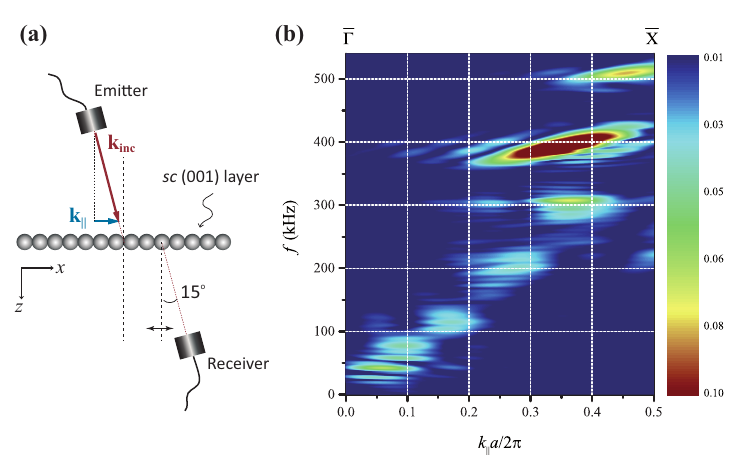
Figure 5. ( a ) schematic representation of the transmission configuration used to measure the guided wave response of the square monolayer of spheres. The incident and transmitted central beam axes lie on a plane containing the normal to the monolayer; the wavevector component parallel to the layer, k (cid:107) , is along the Γ X direction of the square array; and ( b ) the modulus of the space-time ( x - t ) Fourier transform of the pressure transmitted in the free guided regime along the x -direction, plotted versus the reduced wavevector along the Γ X direction.